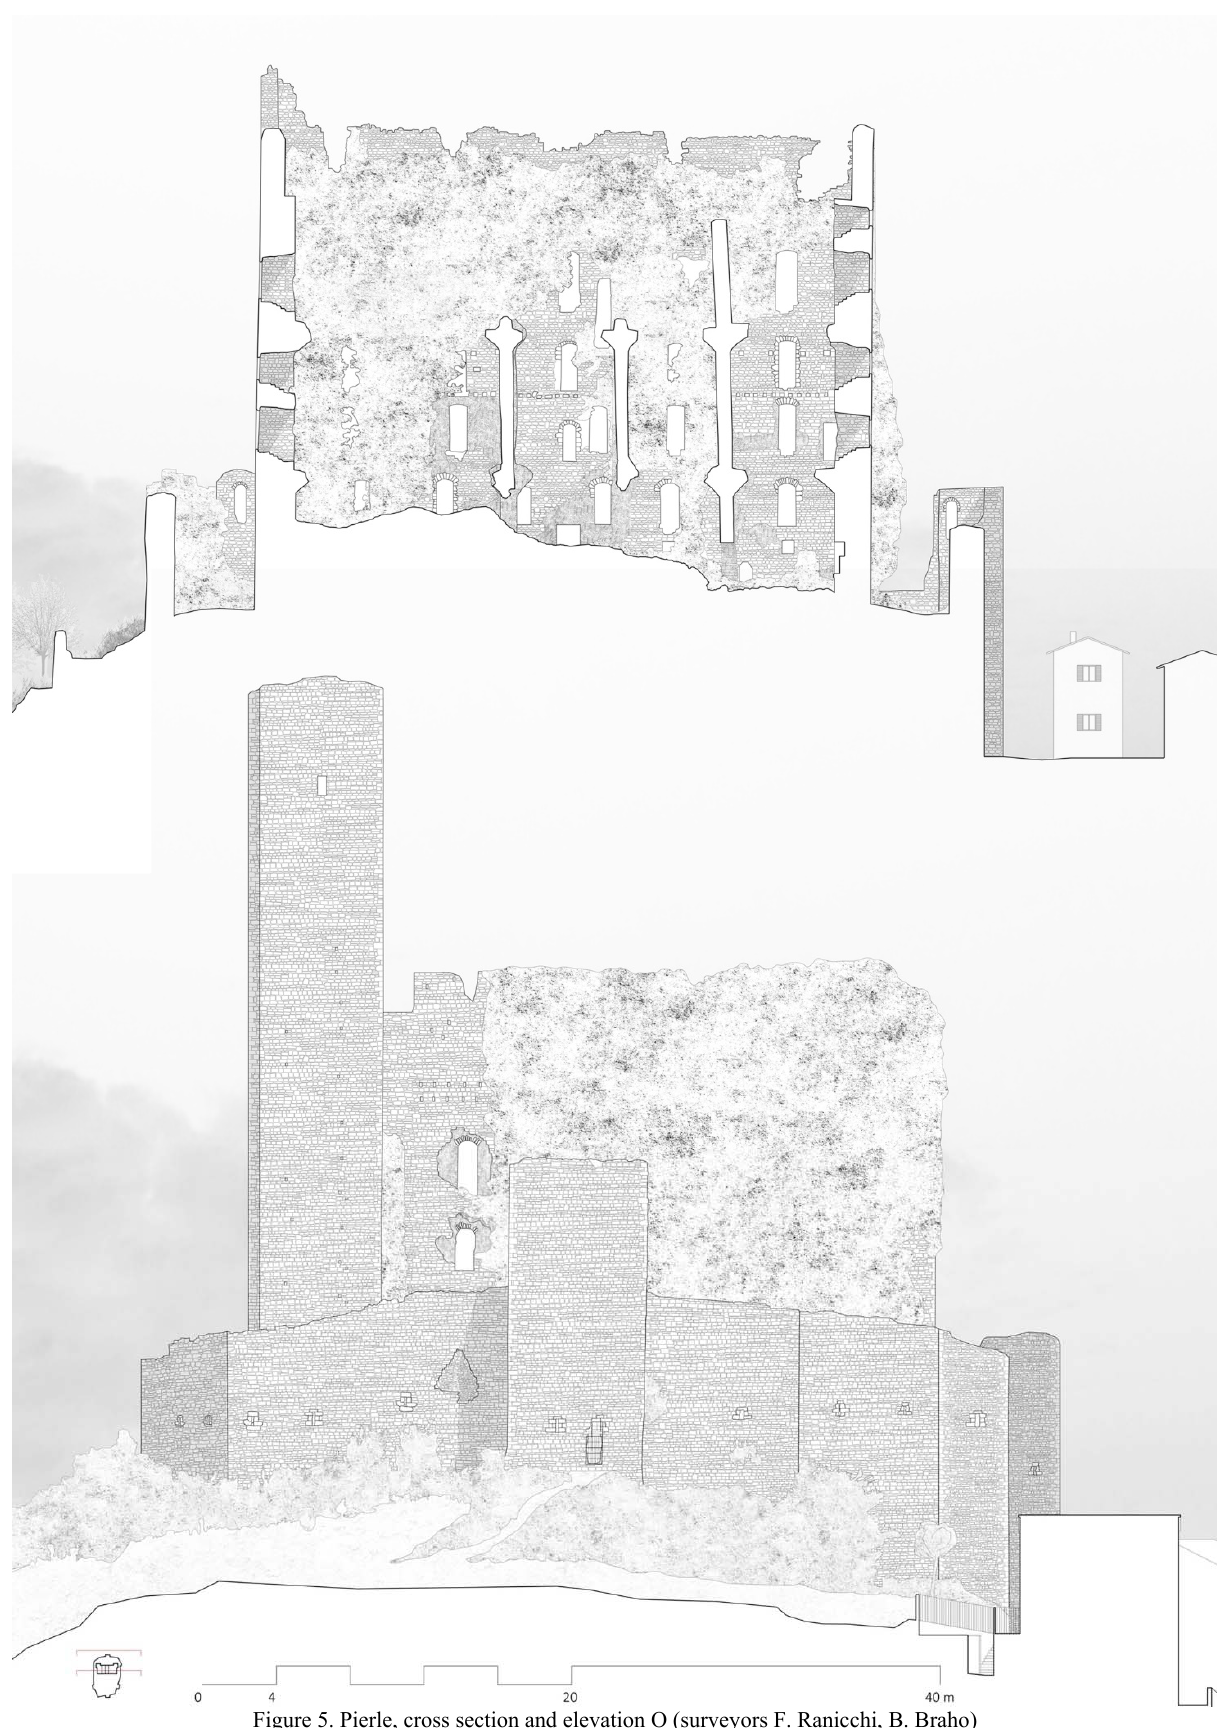
Figure 5. Pierle, cross section and elevation O (surveyors F. Ranicchi, B.